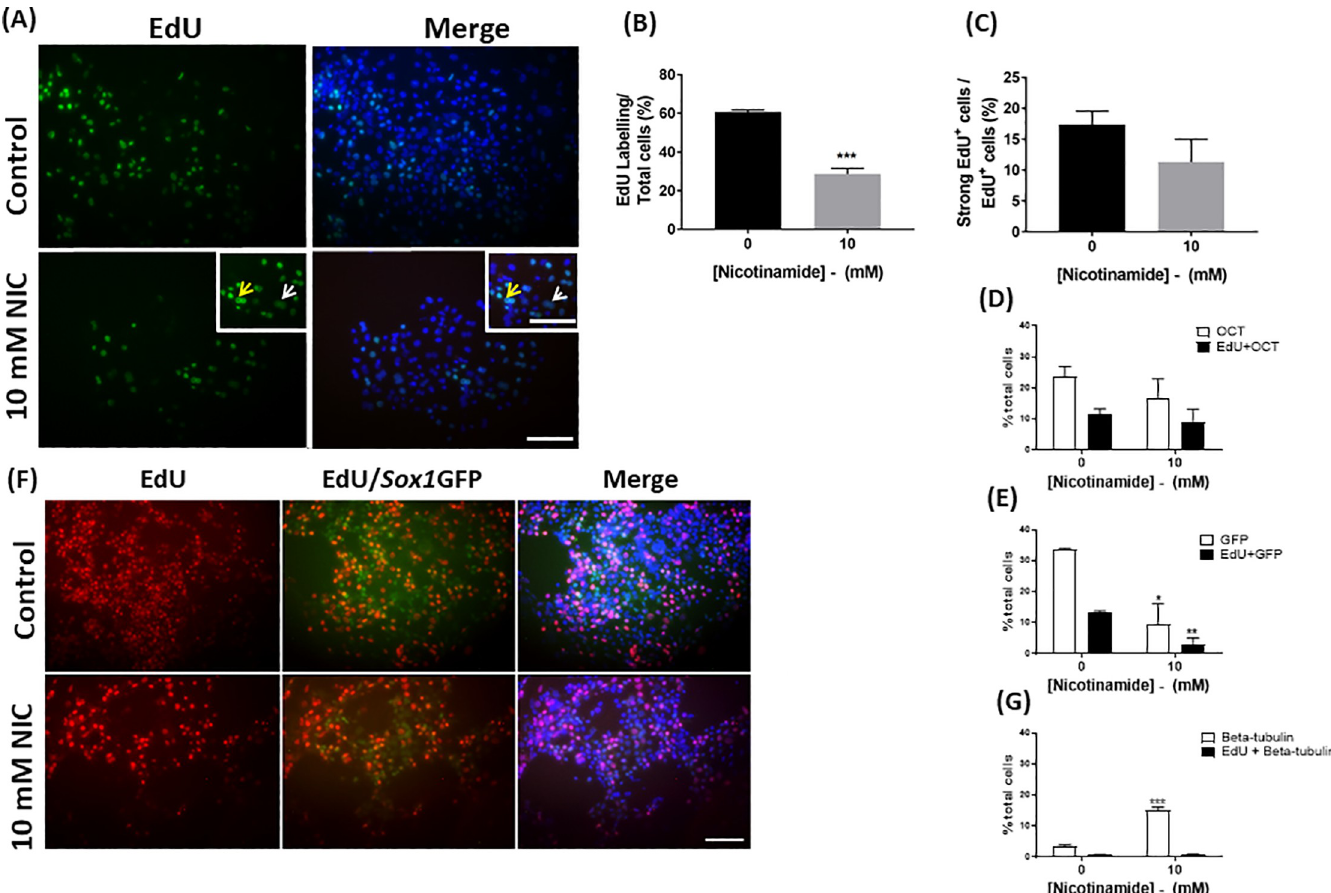
Fig 4. Early nicotinamide administration halts proliferation of Sox1 GFP derived neural progenitor cells. A reduction in cell proliferation was observed in 10 mM nicotinamide-treated cultures versus control groups (A-B). There was no significant difference in the percentage of strongly labelled EdU + cells in cultures treated with nicotinamide from day 0–7, in comparison to untreated groups (C). Scale bar = 50 μ m for main images and 60 μ m for inserts. Arrows indicate cells expressing strong EdU labelling (yellow) and weaker EdU labelling (white). Nicotinamide treatment caused a slight reduction in the percent of Oct4-expressing cells by day 7, but did not alter the percent of EdU-labelled cells within this population (D). Nicotinamide treatment significantly reduced the percentage of GFP-expressing cells, concomitant with a decrease in the percent of EdU-labelled cells in the Sox1 GFP-positive population (E, F). Nicotinamide treatment significantly enhanced neuron-specific β III- tubulin-expressing cells, without altering the percentage of EdU-labelled cells within the neuronal population (G). Scale bar 100 μ m applies to all low magnification images. ��� p < 0.001, �� p < 0.01, � p < 0.05—comparing 10 mM nicotinamide treatment to the equivalent control